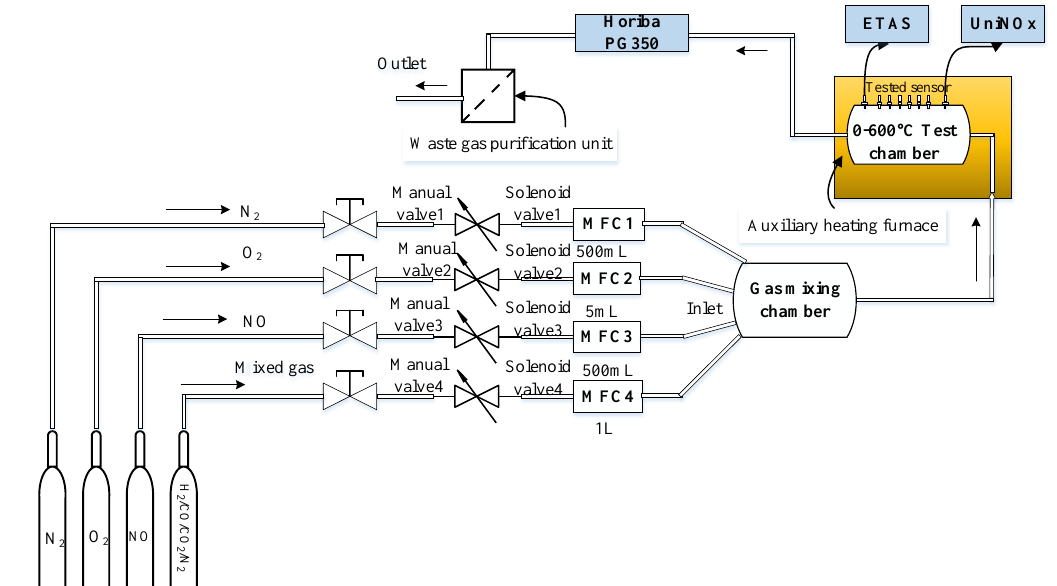
Figure 6. NOx synthetic gas equipment.